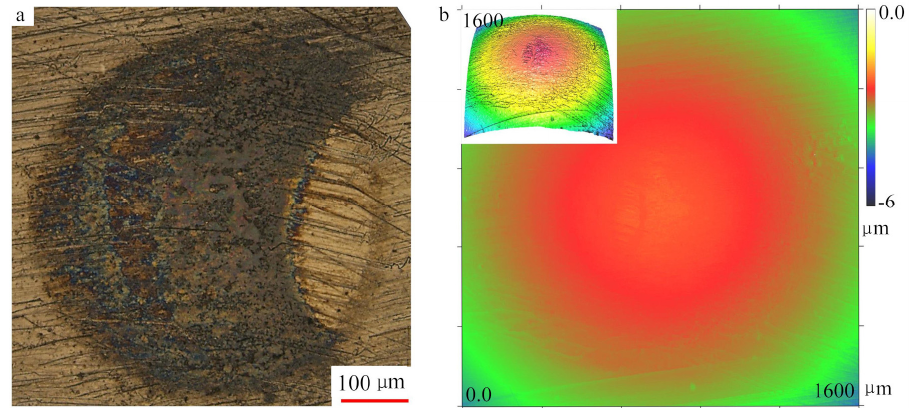
Figure 5. Photomicrograph and 3D profile of the contact point on the ball. ( a ) Micrograph of optical microscope; ( b ) surface topography.